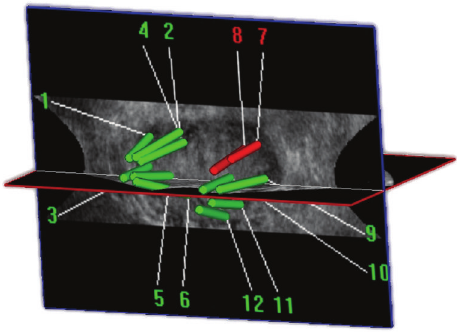
Figure 2: 3D trajectory visualization after biopsy along with mapping and